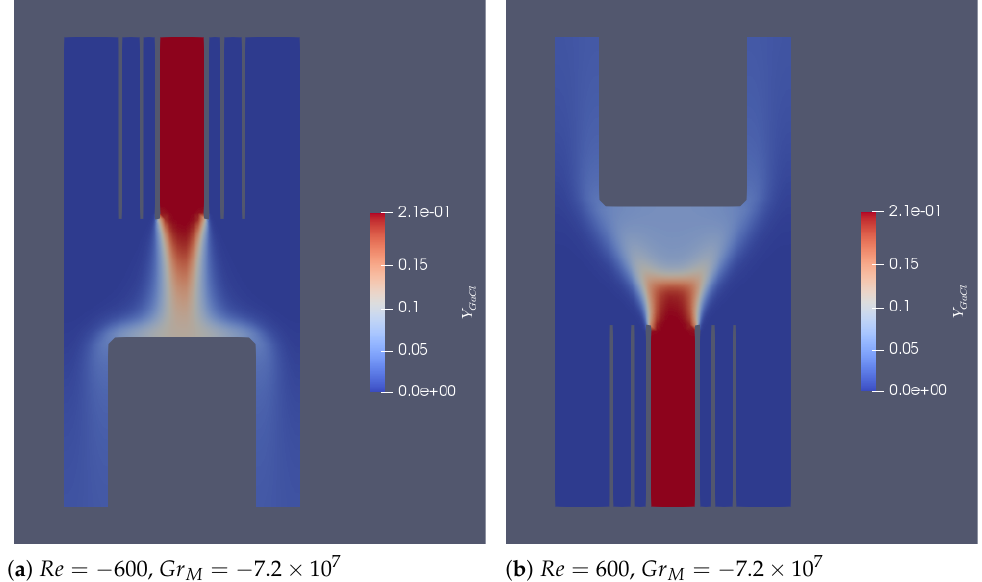
Figure 6. Vertical cut through the HVPE reactor that shows the distribution of Y GaCl . ( a ) Down-Flow reactor, ( b ) Up-Flow